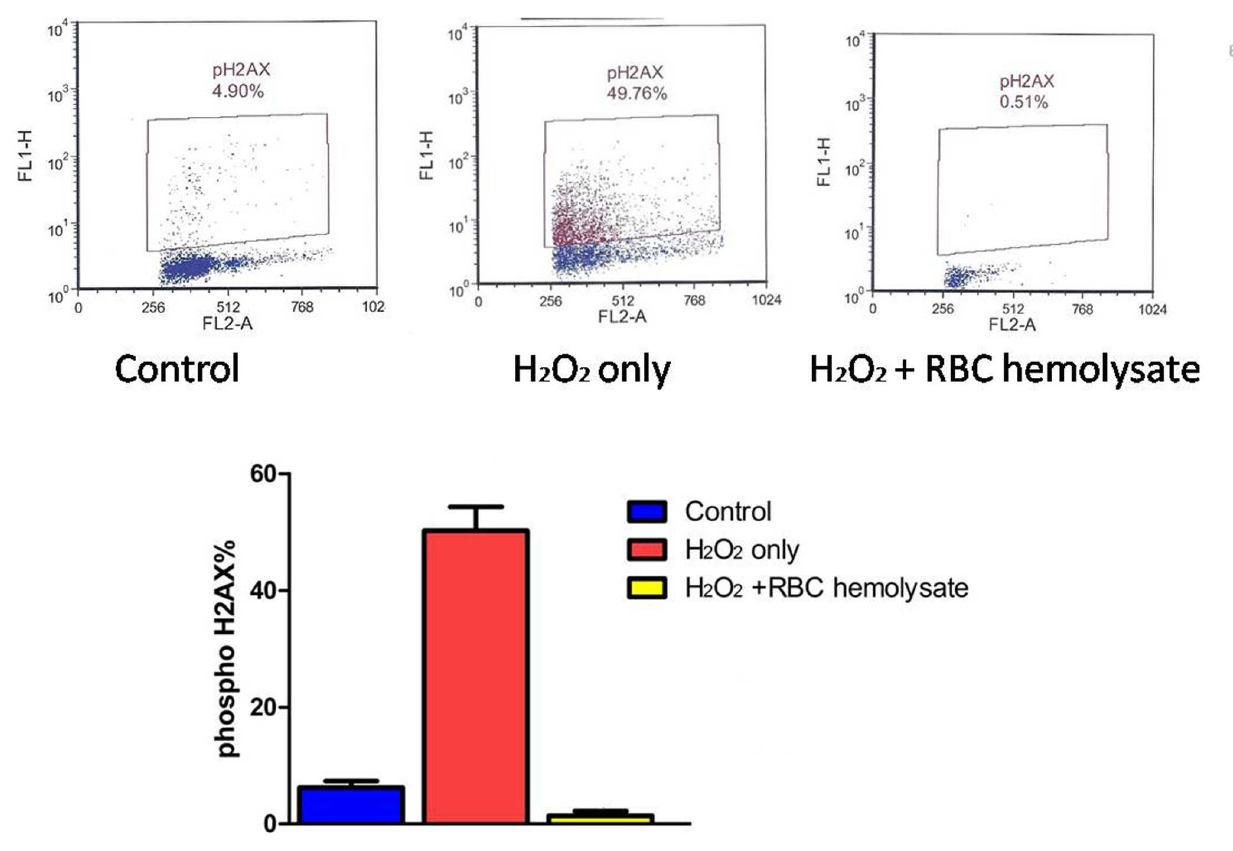
Figure 6. Induction of activation and H2AX phosphorylation in PBMC cells exposed to 200 m M H 2 O2 for 40 min. (a) PBMC were untreated; or (b) treated with 200 m M H 2 O 2 for 40 min;(C) or treated with 200 m mol/L H 2 O 2 for 40 min with hemolysate, each detected immunocytochemically, measured by laser scanning cytometry (scatterplots). The dashed skewed lines show the upper threshold level of PBMC and phosphorylated H2AX expression. % of PBMC expressing H2AX (n=3) is shown in the